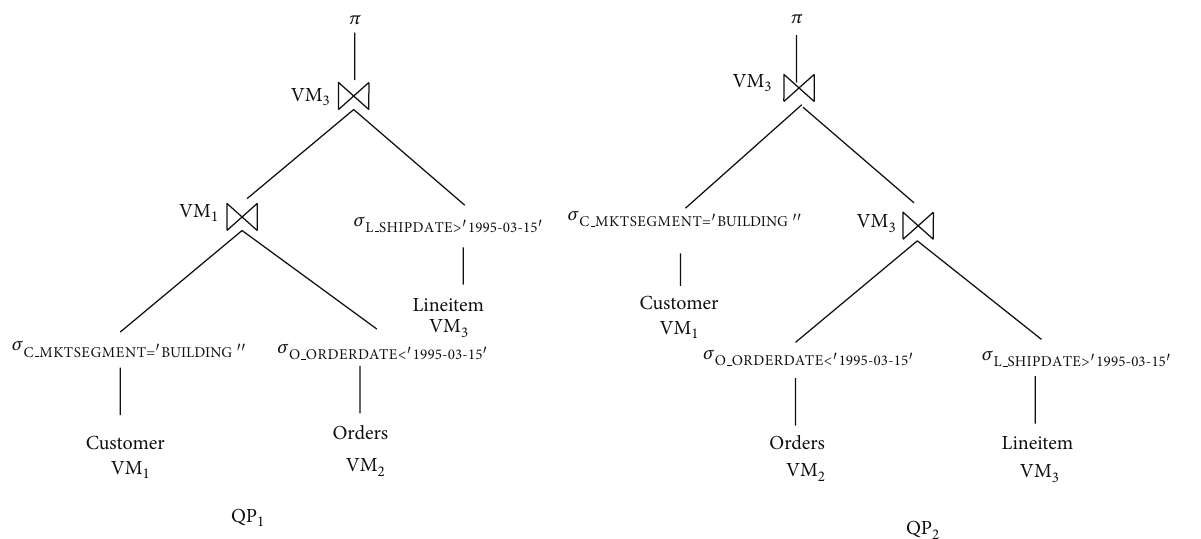
Figure 3: Alternative QPs for TPC-H Q3 query.